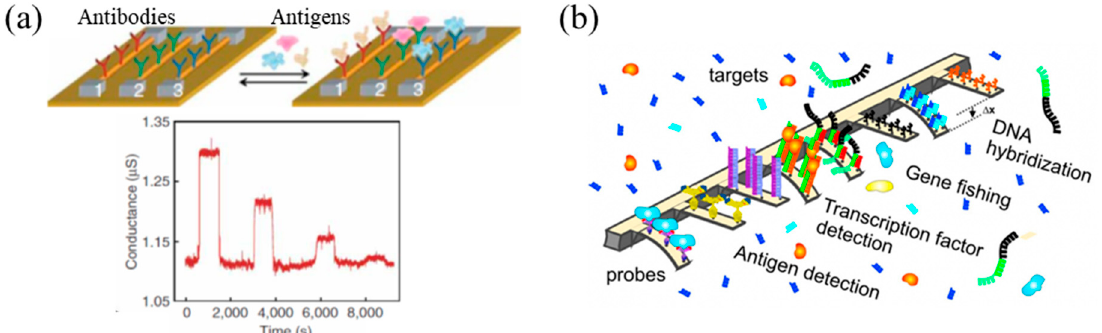
Figure 1. Two non-optical representative sensing technical platforms: ( a ) nano-electronics- nanowires (NWs) and ( b ) micro/nano-mechanics-cantilevers. Reproduced from reference [49] with permission from Springer Nature.